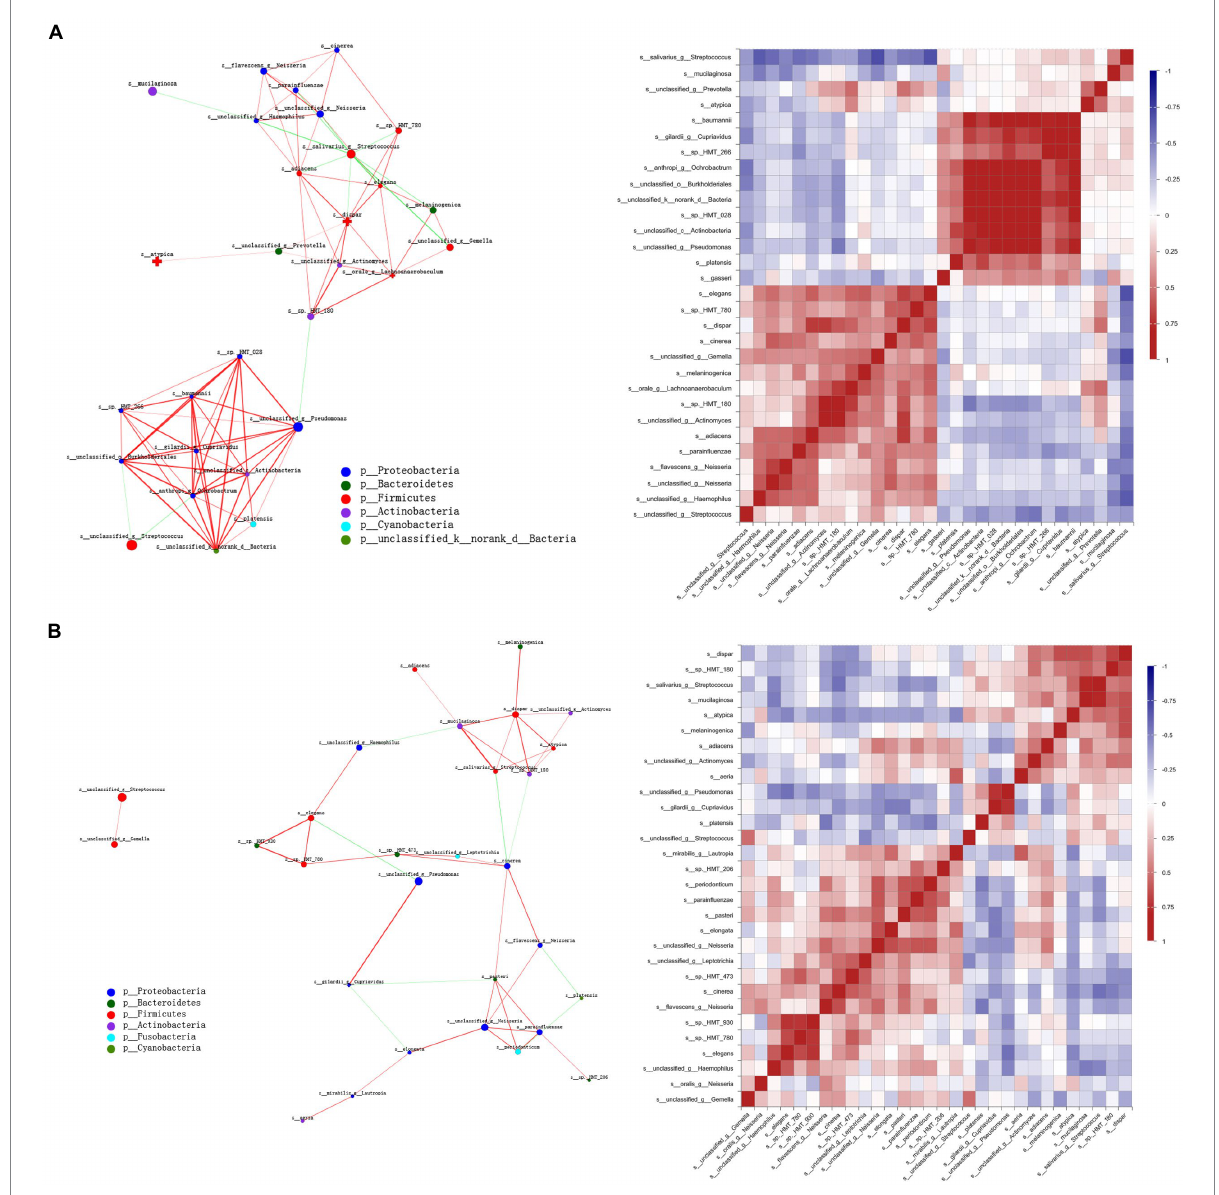
FIGURE 6 Microbial correlation networks of saliva microbiota in preterm infants. The network shows Spearman’s correlation coefficient calculation of 30 most abundant bacterial species together with significant associations ( p < 0.05). Apart from that, the size of the nodes suggests the abundance of species, whereas the color of the connection reveals positive (red) and negative (green) correlations. (A) The PT0 group. (B) The PT1